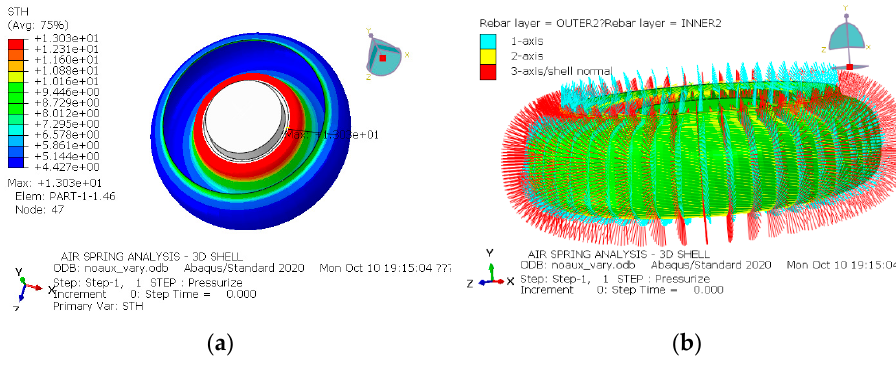
Figure 11. Initial conditions of air spring analysis: ( a ) Distribution of thickness; ( b ) Vector distribution for ply angles in variable ply angle model.